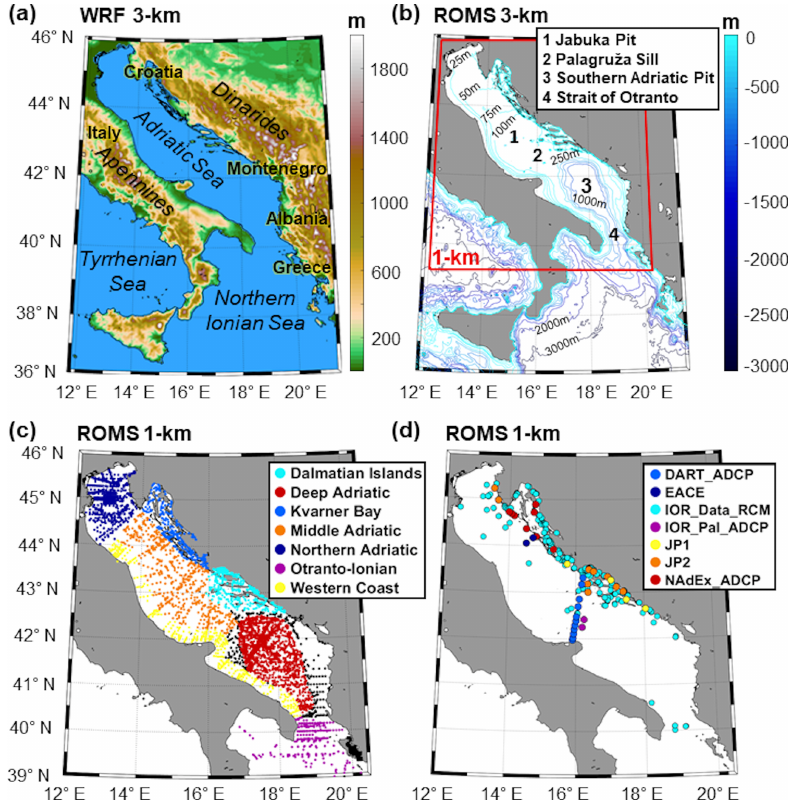
Figure 1. (a) AdriSC WRF 3km domain and orography with geographical locations. (b) AdriSC ROMS 3km and ROMS 1km domains with bathymetry. The location of both (c) conductivity–temperature–depth (CTD) observations separated into seven subdomains and (d) acoustic Doppler current profiler (ADCP) or rotor current meter (RCM) measurements from seven different